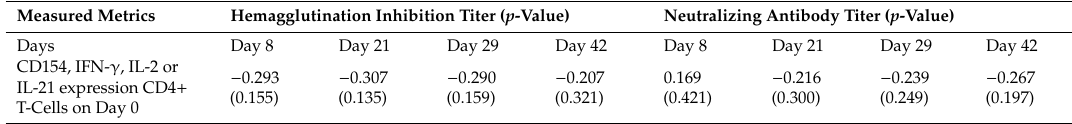
Table 5. Correlation of baseline CD4 + T cell response with post vaccination antibody responses. Measured Metrics Hemagglutination Inhibition Titer ( p -Value) Neutralizing Antibody Titer ( p -Value)